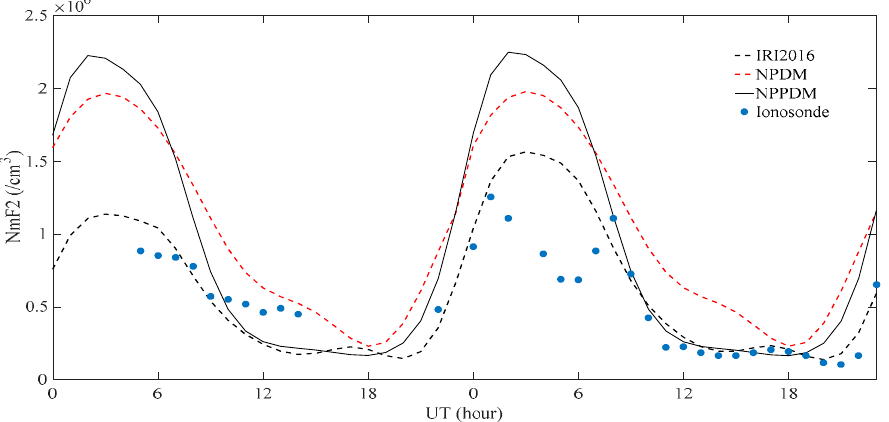
Figure 15. Variations of hourly mean of NPPDM (red solid lines), IRI2016 (black dotted lines) and NPDM (red dotted lines) as a function of UT in comparisons with ionosonde observation (dots) during 20-21 November 2003 .